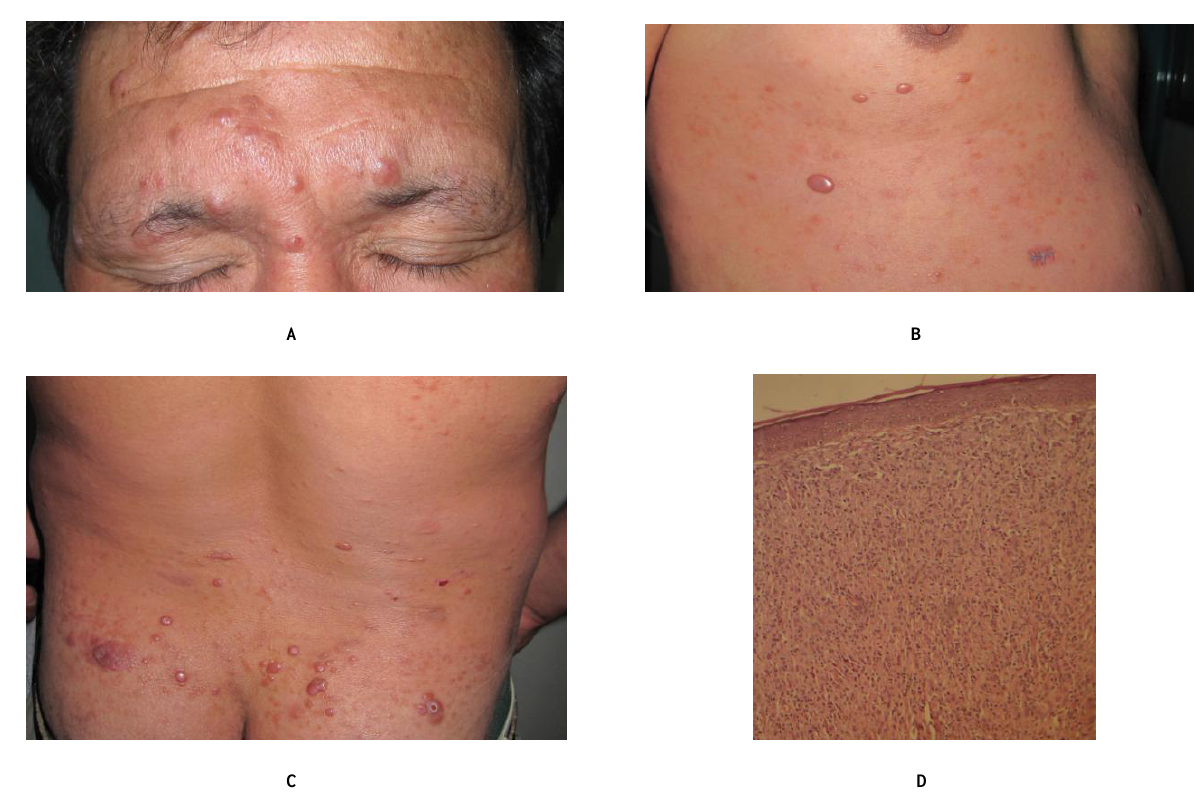
FIGURE 1. Erythematous/coppery papules and nodules appearing on the face and body (A–C), with no apparent granuloma